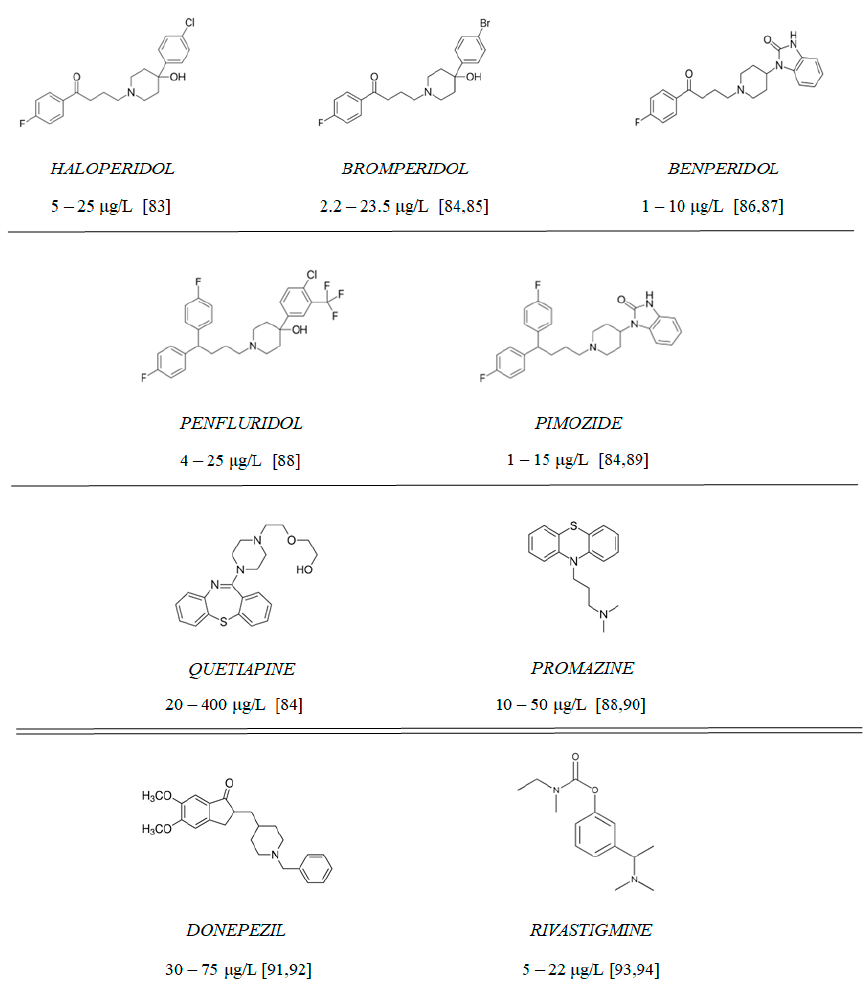
Figure 10. Chemical structure of tested antipsychotics (with therapeutic plasma concentrations according to the literature [83–94]) and clinically approved AChE inhibitors: rivastigmine and donepezil.